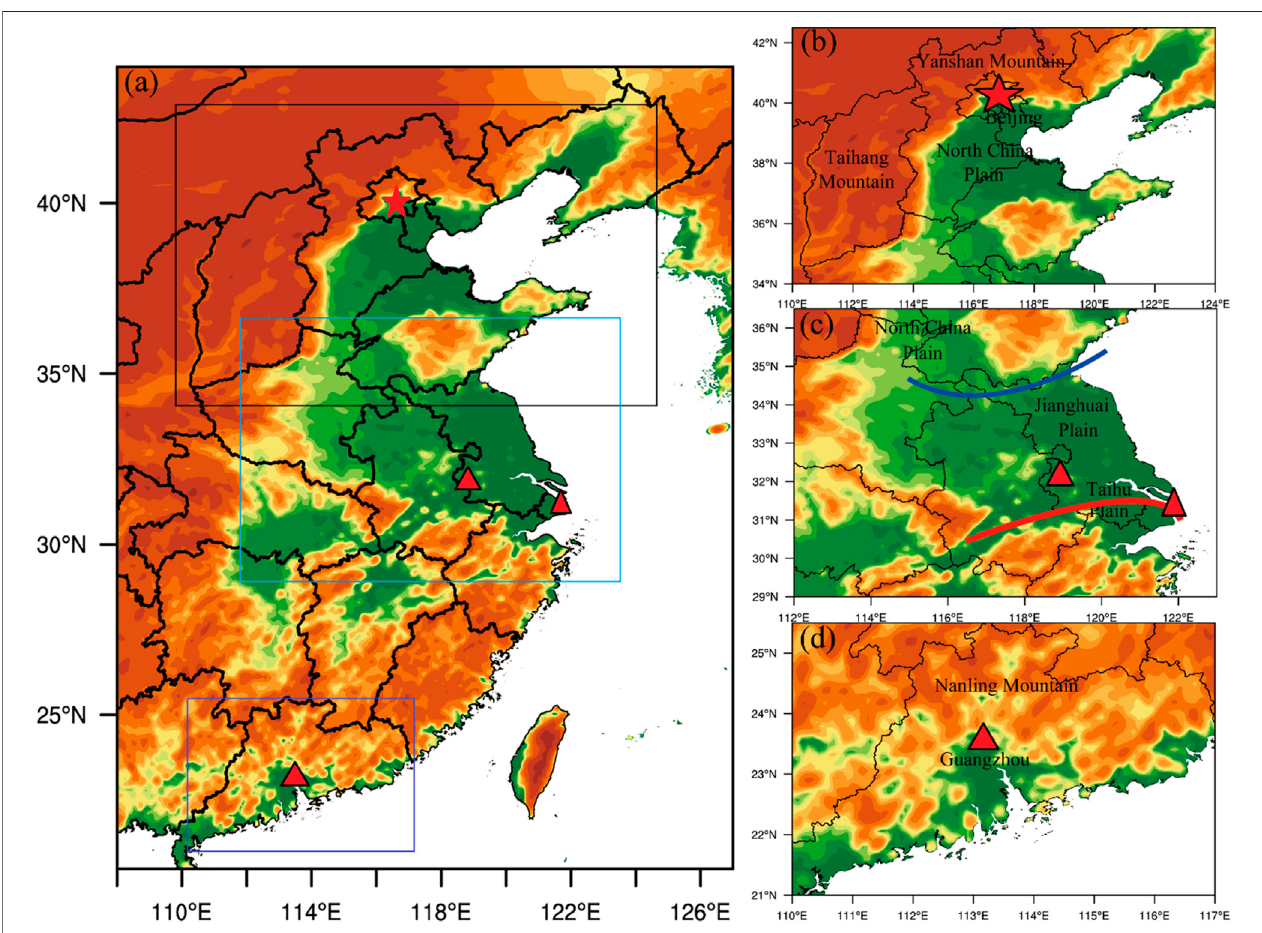
FIGURE 8 | Schematic diagram of geography attributed fi xed boundary of the North China Plain (B) , geography attributed fi xed boundary of the Pearl River Delta (C) , the airmass attributed movable boundary of the Jianghuai area (D) , and the geographic connections between them (A) (blue line: cold front, red line: warm front.)